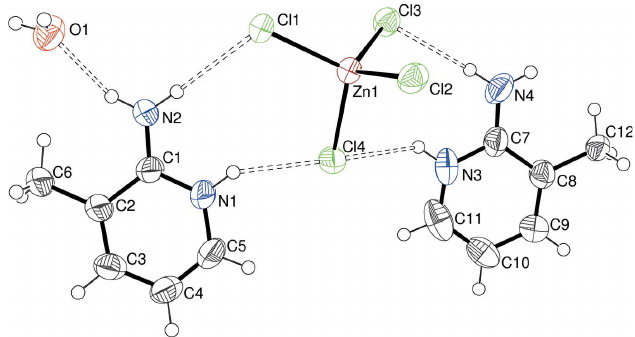
Figure 5 The asymmetric unit of (V) showing 50% displacement ellipsoids. Hydrogen bonds are indicated by double-dashed